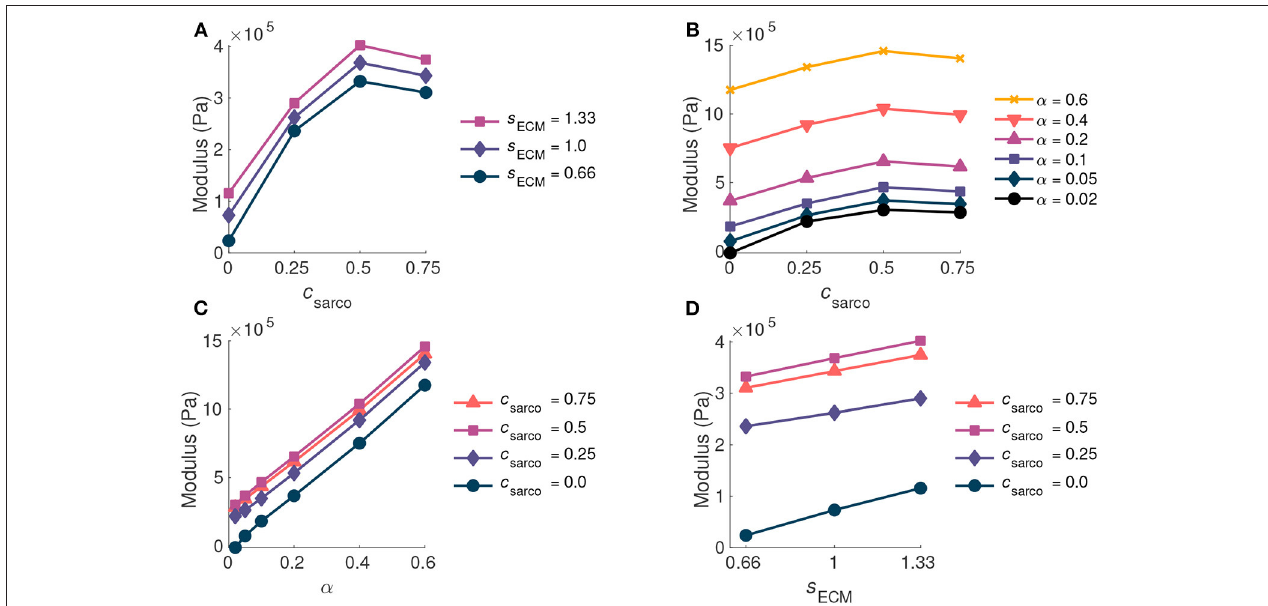
FIGURE 6 | Plot of whole muscle modulus vs. c sarco (A,B) , α (C) , and s ECM (D) at optimal length ( ¯ λ tot = 1.0). Where α is the ECM volume fraction, s ECM is the ECM stiffness factor, and c sarco is the shift in the sarcomere stretch. In (A,D) α is held constant at 0.05, and in (B,C) s ECM is held constant at